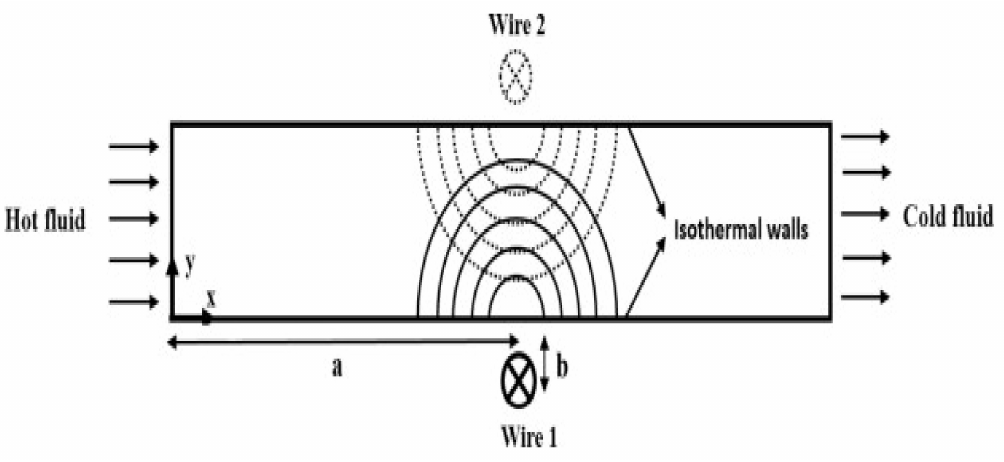
Figure 4. Magnetic field distribution to enhance the heat transfer [64] © Elsevier,